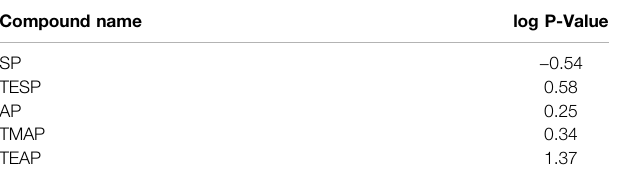
TABLE 1 | Lipophilic indexes (log P) for the 2-oxo phosphonates and their esters usedinthiswork.Thestructuresarepresentedin Figure1